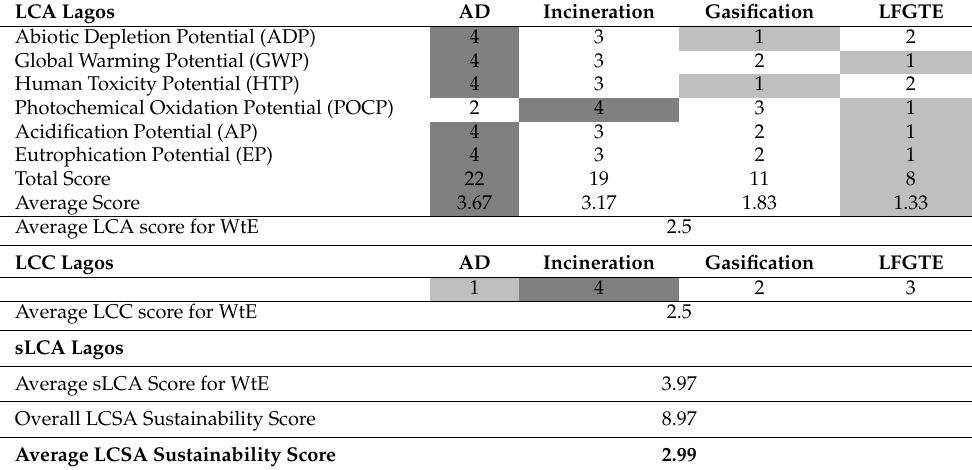
Table 2. Overall LCSA outcomes of WtE in Lagos using the Scoring and Ranking Approach. LCA Lagos